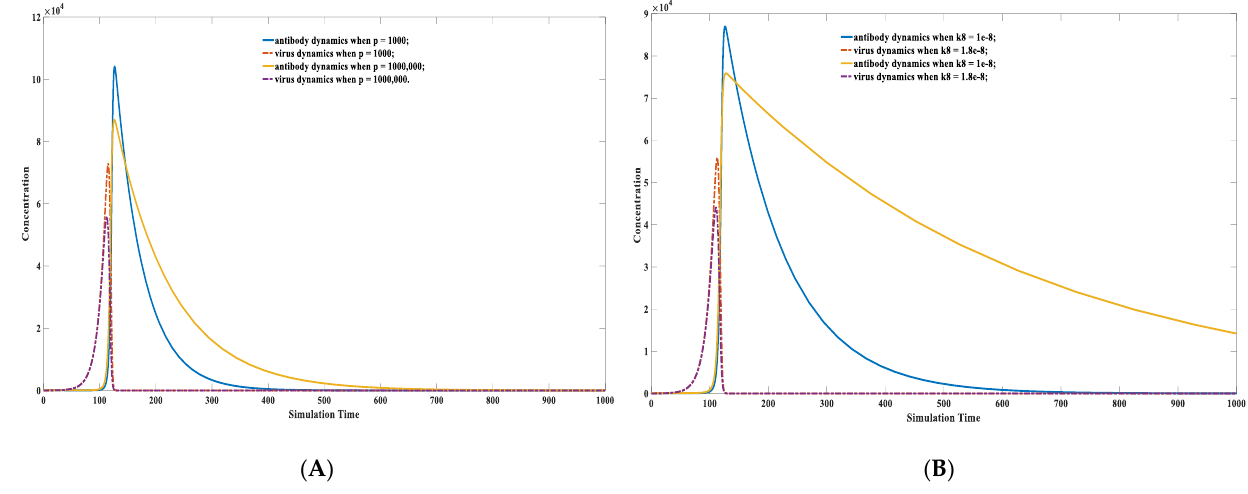
Figure 3. Antibody and virus dynamics modeling using different p (0) value. p (0) represents the concentration of environmental antigens. The virus-antibody dynamics are modeled under different environmental antigen concentrations ( A ) and different environmental antigen attributes ( B ). As shown in ( A ), the antibody decay rate is significantly slower (shown in solid yellow curve) when there is a large amount of environmental antigen-like substances. The parameter set we used is: x (0) = 0, y (0) = 100, z (0) = 10, p (0) = 1000 or p (0) = 1,000,000, k 1 = 0.1, k 2 = 1 × 10 − 5 , k − 2 = 1 × 10 − 14 , k 3 = 1, k 4 = 2, k 5 = 0.02, k 6 = 0.02, k 7 = 1 × 10 − 8 , k − 7 = 1 × 10 − 14 . As shown in ( B ), the antibody decay rate is significantly slower (shown in solid yellow curve) when k 8 sets a large value which corresponds to a better binding kinetics between environmental antigen-like stuff and its corresponding antibody. The parameter set we used is: x (0) = 0, y (0) = 100, z (0) = 10, p (0) = 1,000,000, k 1 = 0.1, k 2 = 1 × 10 − 5 , k − 2 = 1 × 10 − 14 , k 3 = 1, k 4 = 2, k 5 = 0.02, k 6 = 0.02, k 7 = 1 × 10 − 8 or k 7 = 1.8 × 10 − 8 , k − 7 = 1 × 10 − 14 .